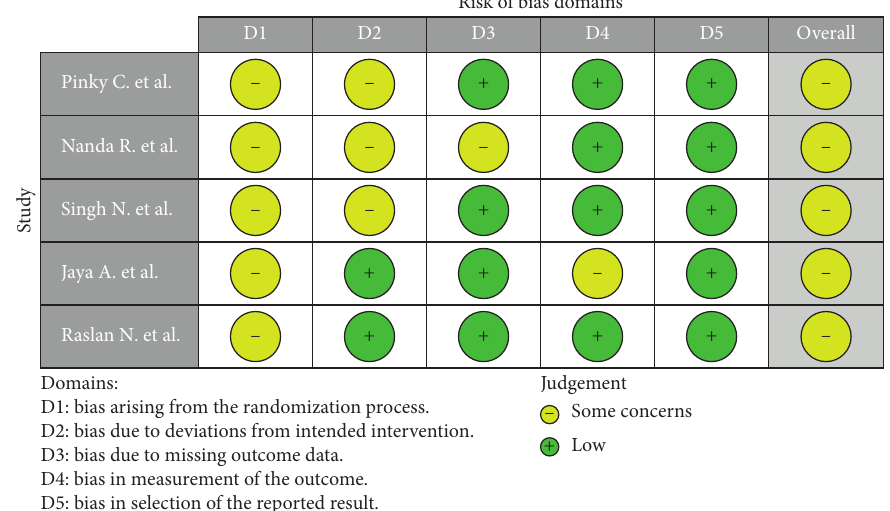
Figure 2: Risk-of bias summary (green indicates low risk of bias and yellow indicates some concerns of bias).